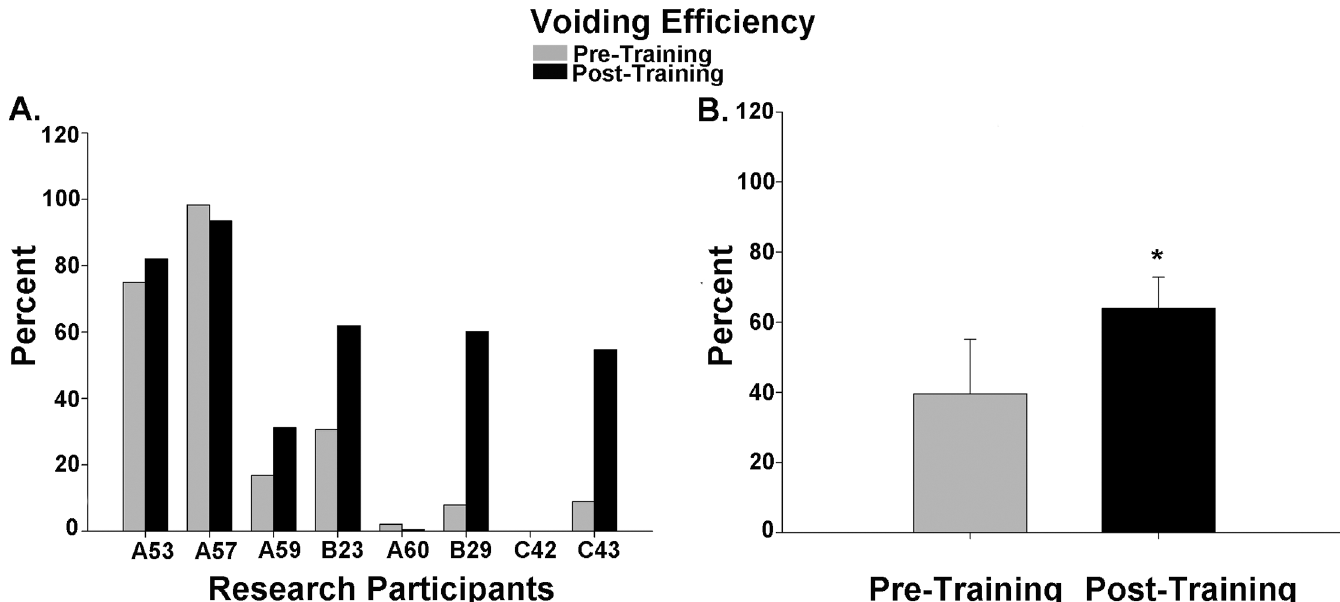
Fig 5. Voiding efficiency data summary. A comparison of pre- and post-training voiding efficiency (VE) values in the eight research participants. While the majority of participants demonstrated an improvement in VE, participant C42 did not have a leak/void and participant A60 just leaked a few drops. When considering the six research participants that had a measurable efficiency, a significant improvement in VE values occurred collectively post-training (p = .046; 39.6 ± 15.5% vs 63.9 ± 8.9%).